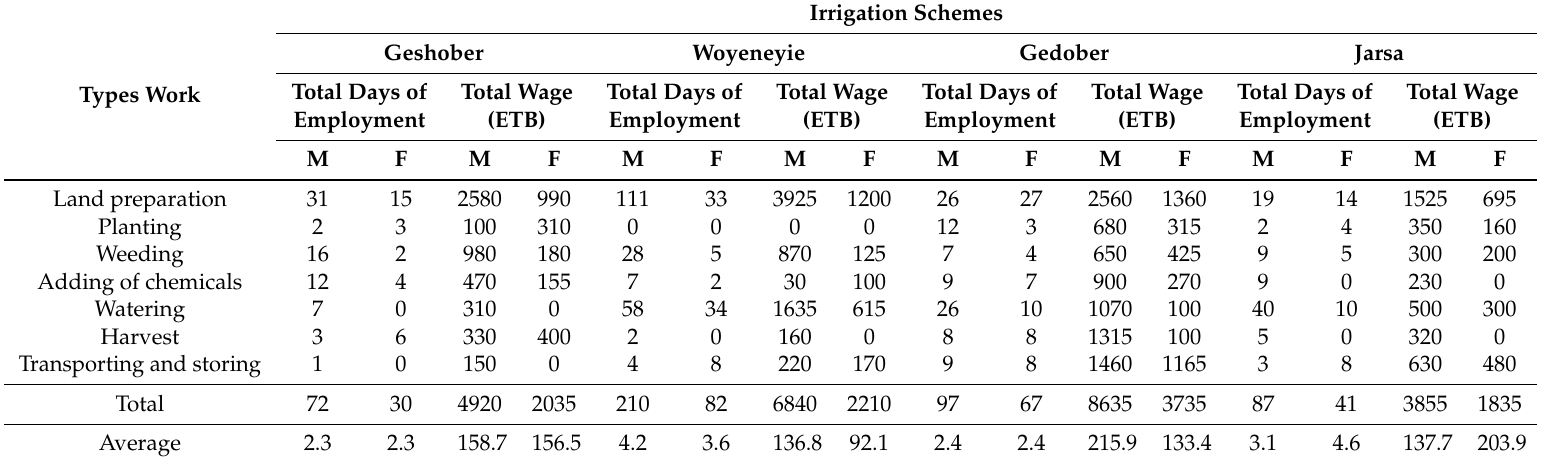
Table 7. Labor demand in the SSI schemes (NB: 1 USD « 20 ETB), Sanka (Geshober and